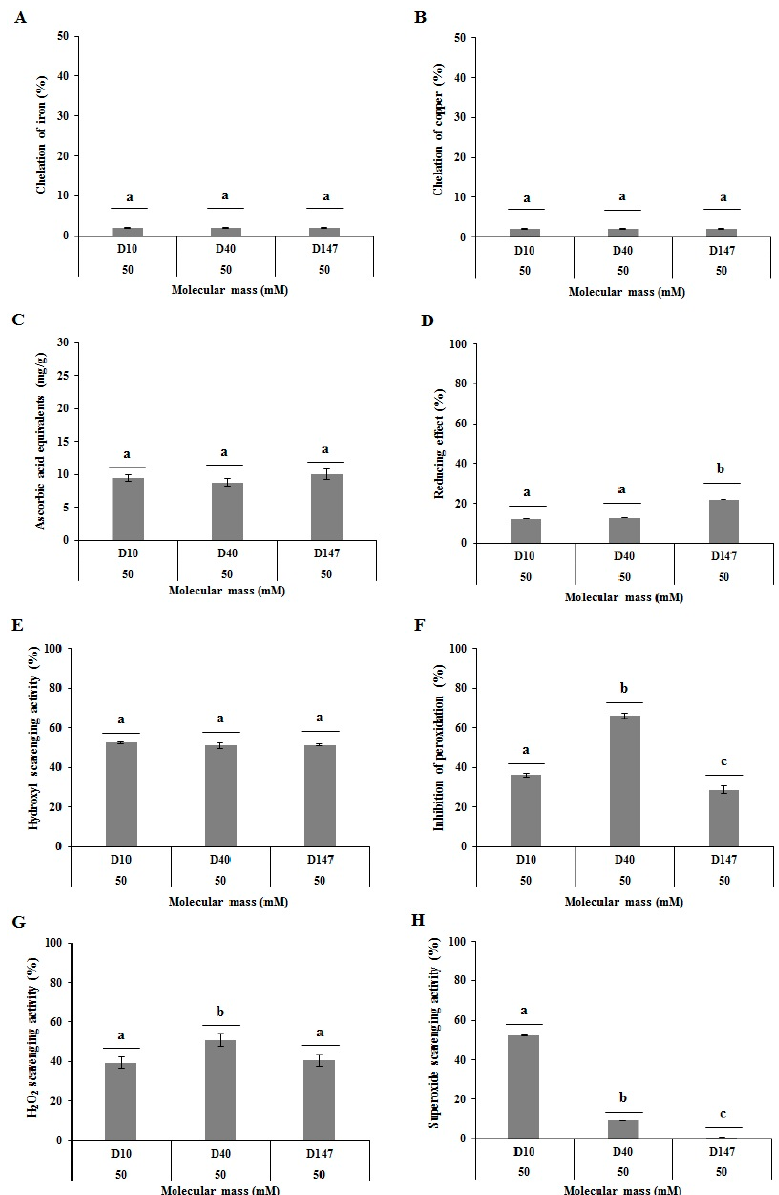
Figure 2. Antioxidant activities of D10, D40 and D147. ( A ) Ferrous chelating; ( B ) copper chelating; ( C ) total antioxidant capacity; ( D ) reducing Power; ( E ) hydroxyl radical scavenging; ( F ) inhibiting lipid peroxidation; ( G ) hydrogen peroxide radical scavenging; and ( H ) superoxide radical scavenging. Letters a,b,c represent the significant difference between the samples by the simple variance analyses (one-way ANOVA) followed by the Tukey–Kramer ( p < 0.05) test.